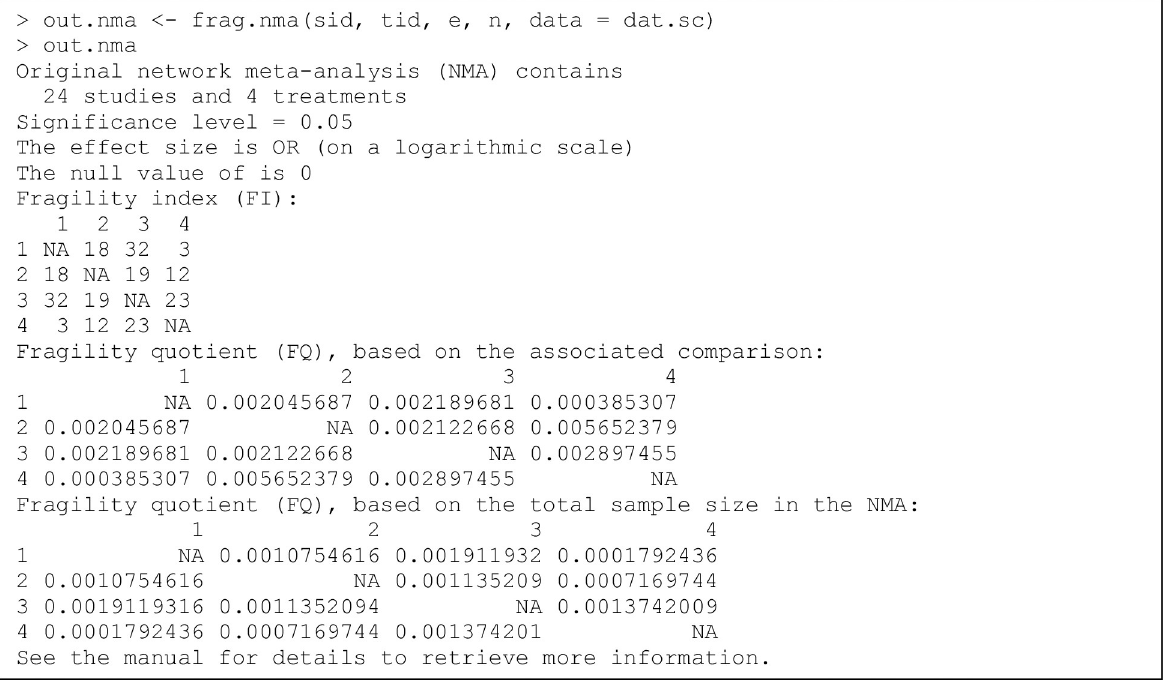
Fig 5. Output from the function frag.nma()